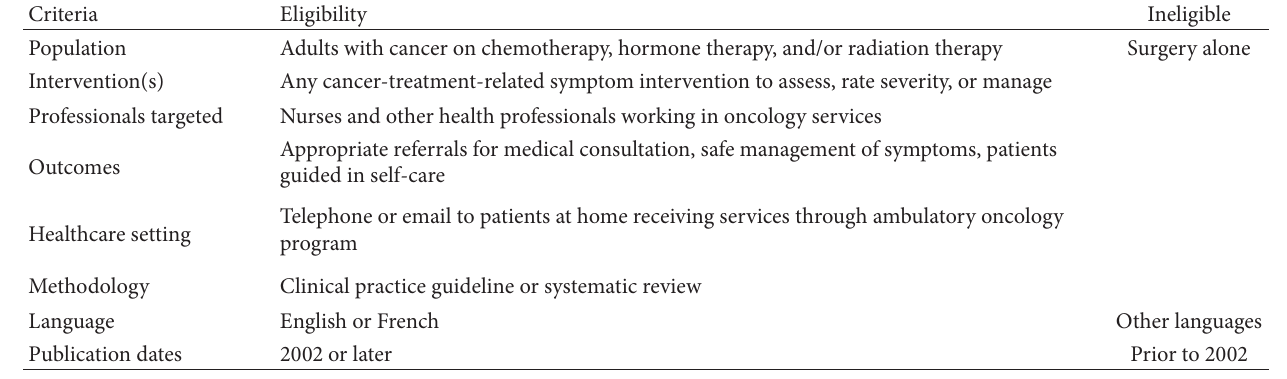
Table 1: Criteria for searching and screening eligibility of potential citations.